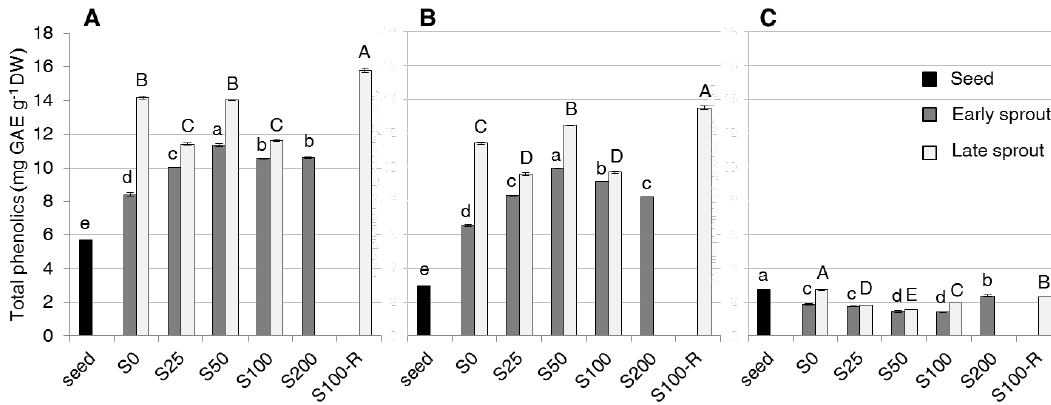
Figure 1. Total ( A ), free ( B ) and bound ( C ) phenolics (mg GAE g − 1 DW) in seeds, early and late sprouts of rapeseed sprouted and grown with salt (NaCl) concentration 0, 25, 50, 100, 200 mM (S0, S25, S50, S100, S200, respectively) or sprouted with 100 mM and then grown with distilled water as recovery treatment (S100-R). Average values of duplicate determinations ± standard error are depicted. Different letters within each of the Figure 1A–C indicate statistically significant differences at p = 0.05 (Fisher’s least significant difference, LSD). Lower case letters are for comparison within early sprouts; upper case letters for comparison within late sprouts.